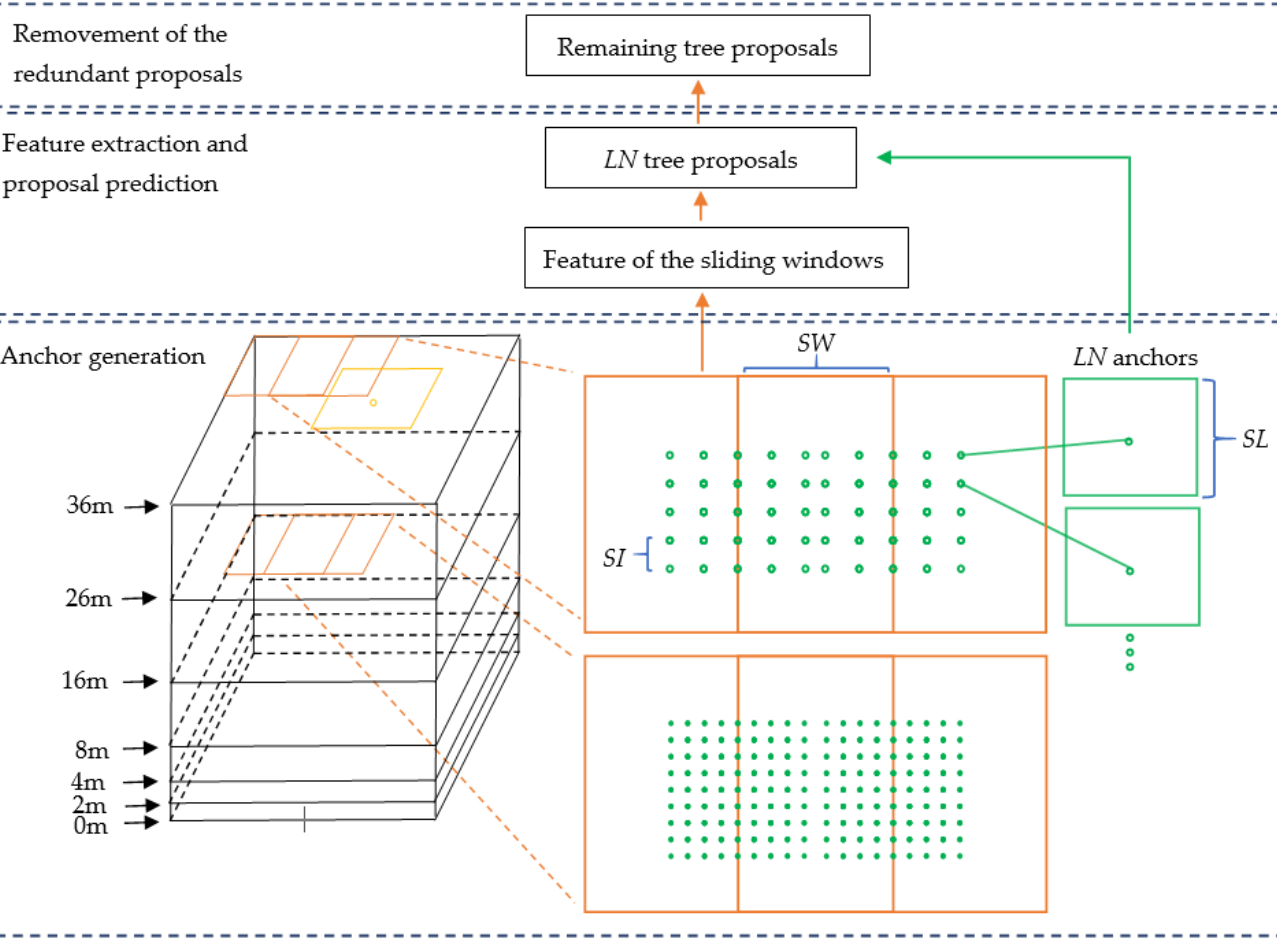
Figure 2. Structure of the 3D proposal generation stage. The black boxes are 3D bounding boxes at different height levels of a plot. The orange boxes are sliding windows. The yellow point is a local maxima point and the yellow box is a sliding window located at the point. The green points are dense location indexes. The green boxes are dense anchors. SW is the Stride of the sliding Window. SI is the Stride of the location Index. SL is the Side Length of anchors. LN is the Location index Number.